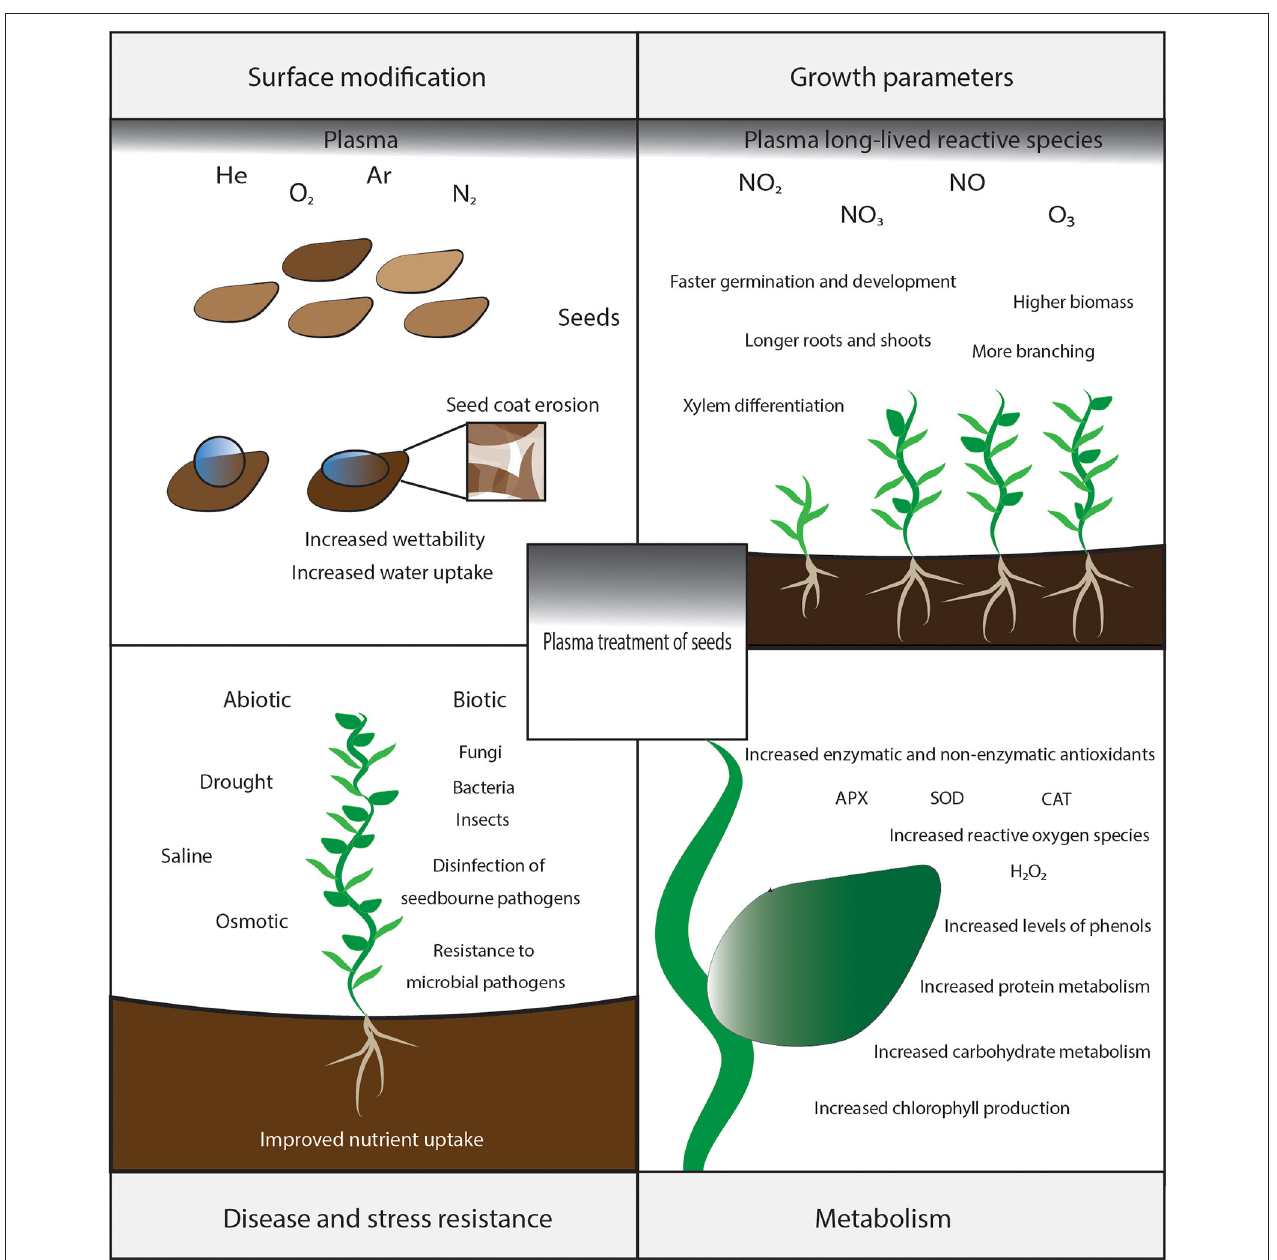
FIGURE 1 | Effects of plasma treatment on seeds which includes surface modifications, changing growth parameters, modulating disease, and stress resistance through